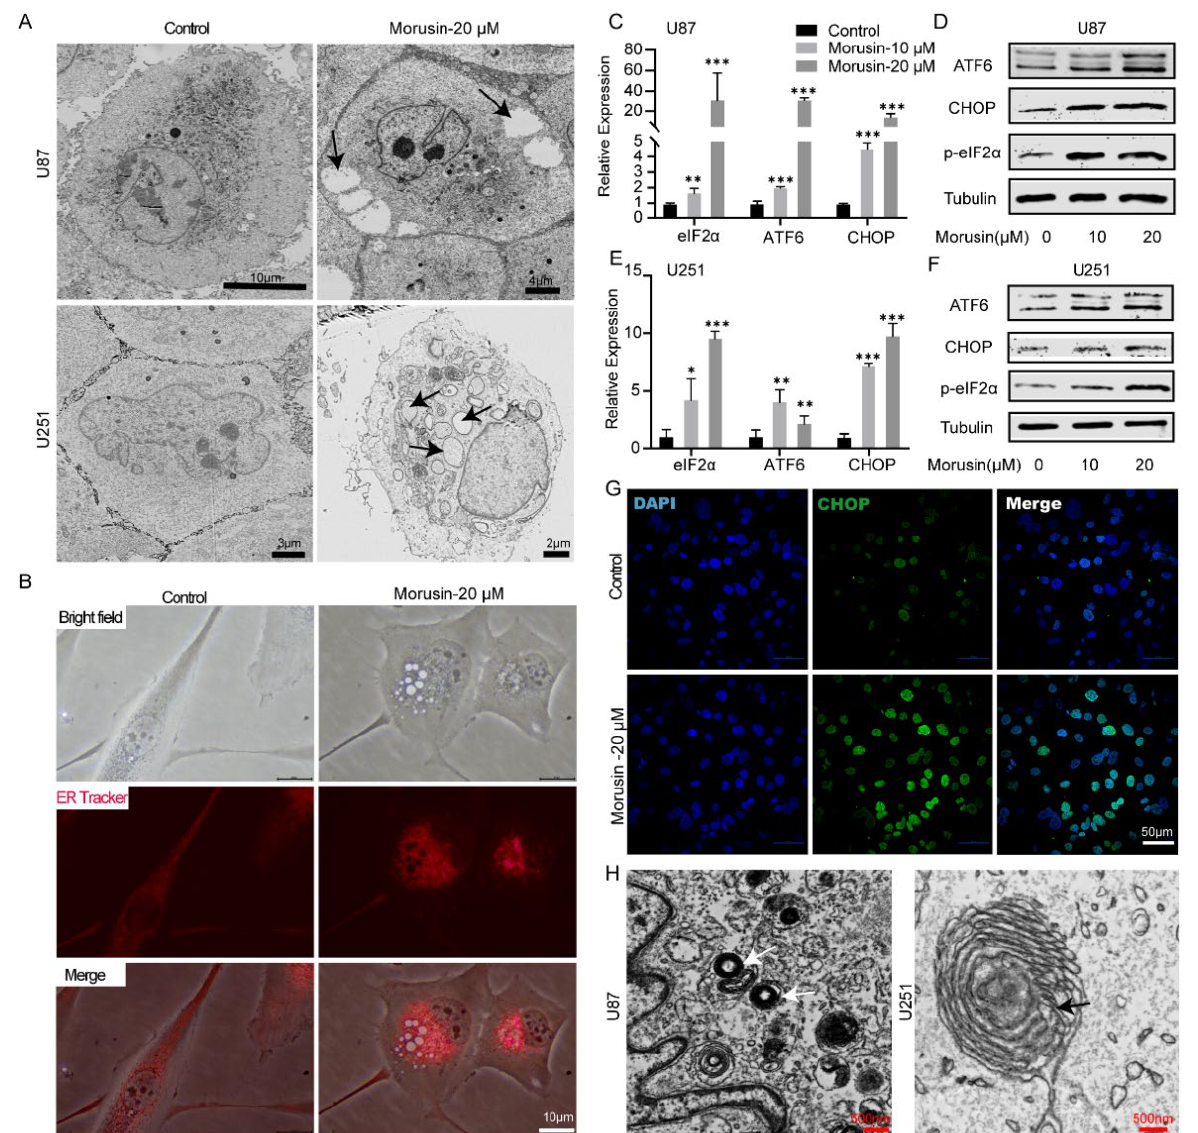
Figure 2. Morusin induced ER stress and UPR in GBM cells. ( A ) Cytoplasmic vacuolation in